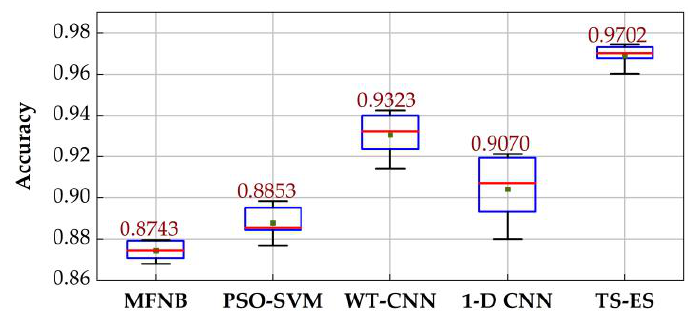
Figure 8. Accuracy of each method.